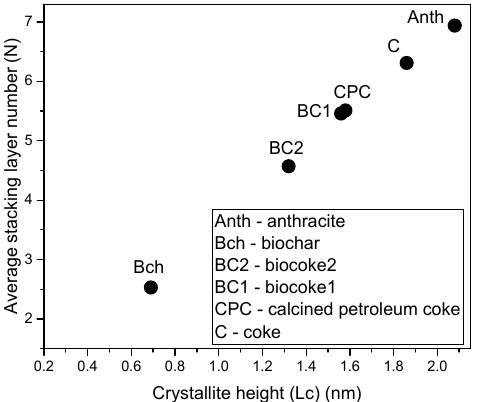
Figure 8. Relationship between the crystallite height (L c ) and crystalline stacking layer number (N).